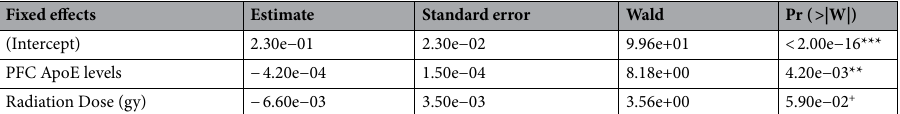
Table 3. Linear generalized estimating equations model results predicting relative prefrontal cortex volumes with apoE in the PFC and radiation dose as independent predictors. *** p < 0.001; ** p < 0.01; + p < 0.1; displayed p -values are uncorrected for multiple